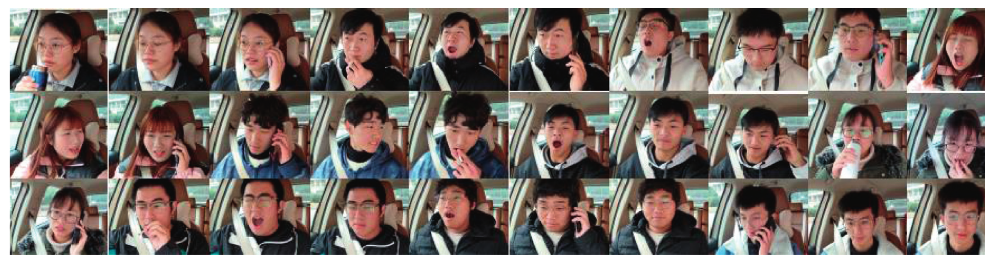
Figure 11: Self-built video image